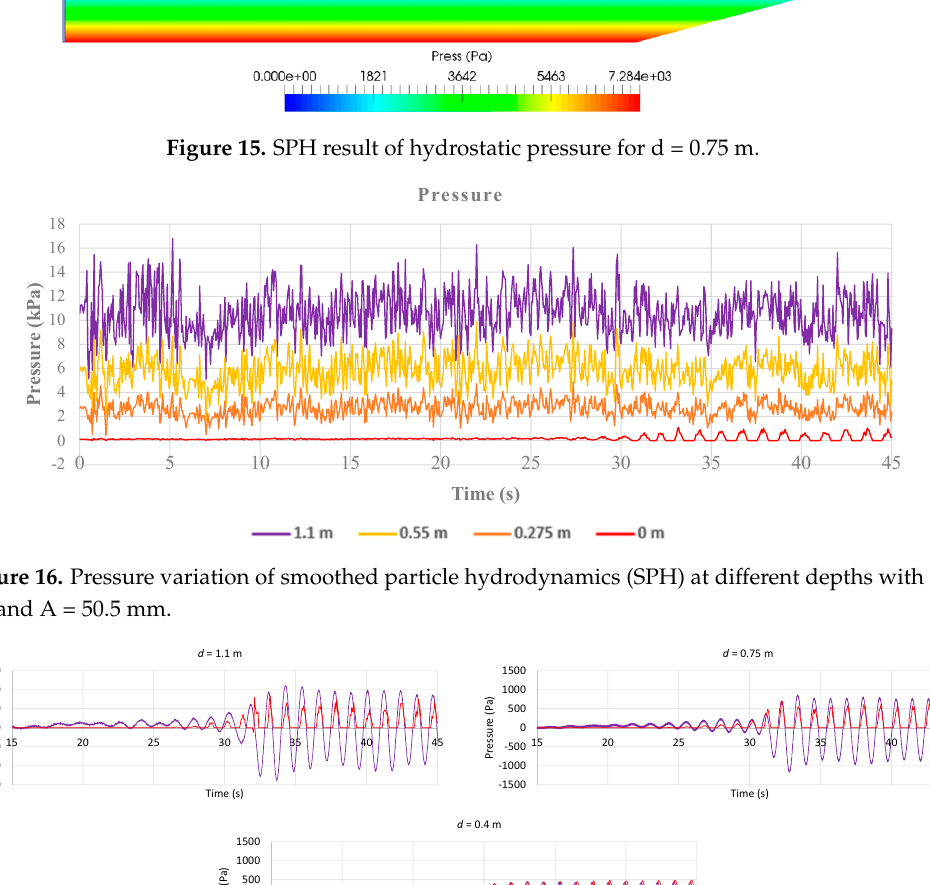
Figure 16. Pressure variation of smoothed particle hydrodynamics (SPH) at different depths with d = 1.1 and A = 50.5 mm.